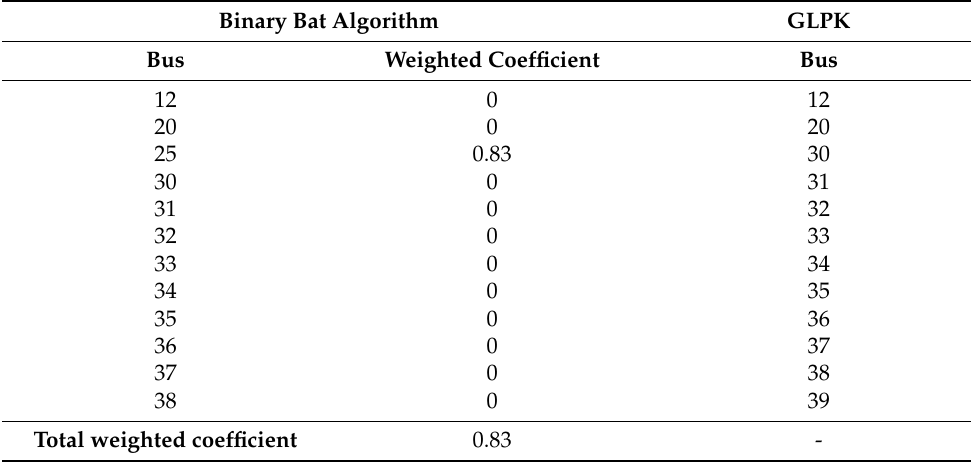
Table 3. Comparison of solutions for the optimal location and number of voltage dip measuring devices for single-phase short